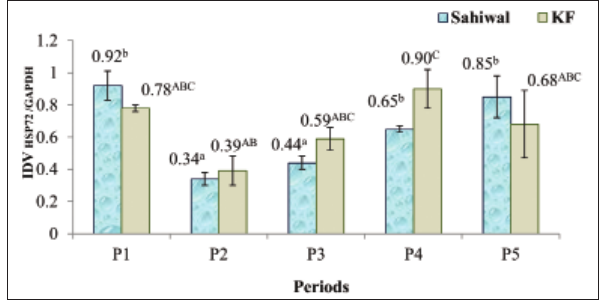
Figure-1: Effect of temperature-humidity index on heat- shock protein 72 mRNA expression of Sahiwal and Karan- Fries. Bars indicate means with standard error. Means of the same breed with different superscripts differ significantly Table-2: Ambient temperature and THI during different periods. Parameters